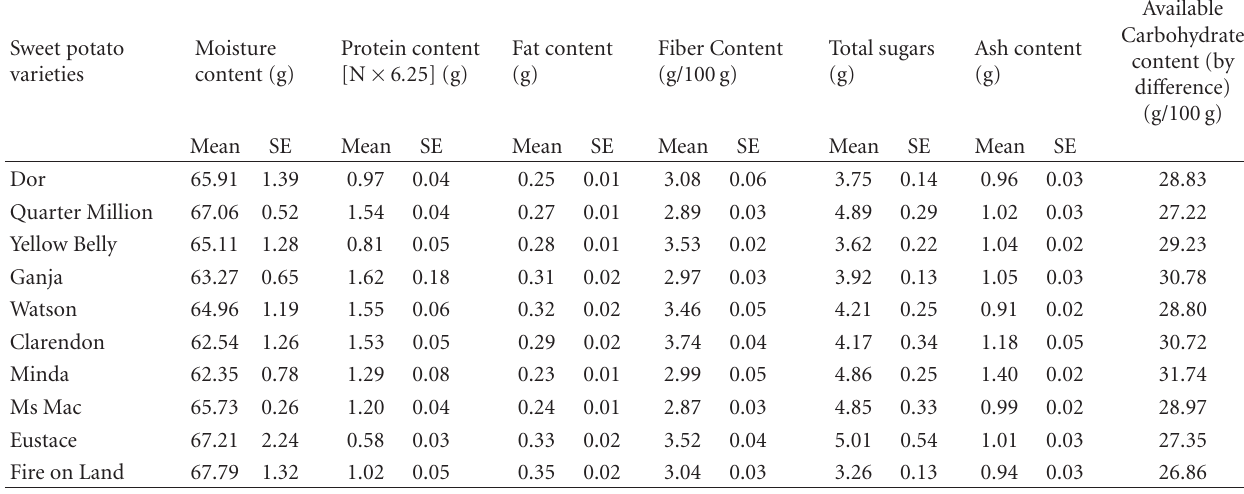
Values are means ± SEM. n = 4. Table 2: Available carbohydrate (CHOg) in 100 g unprocessed sweet potato cultivars ∗ and serving sizes § used for glycemic index determina- tion. Sweet potato varieties